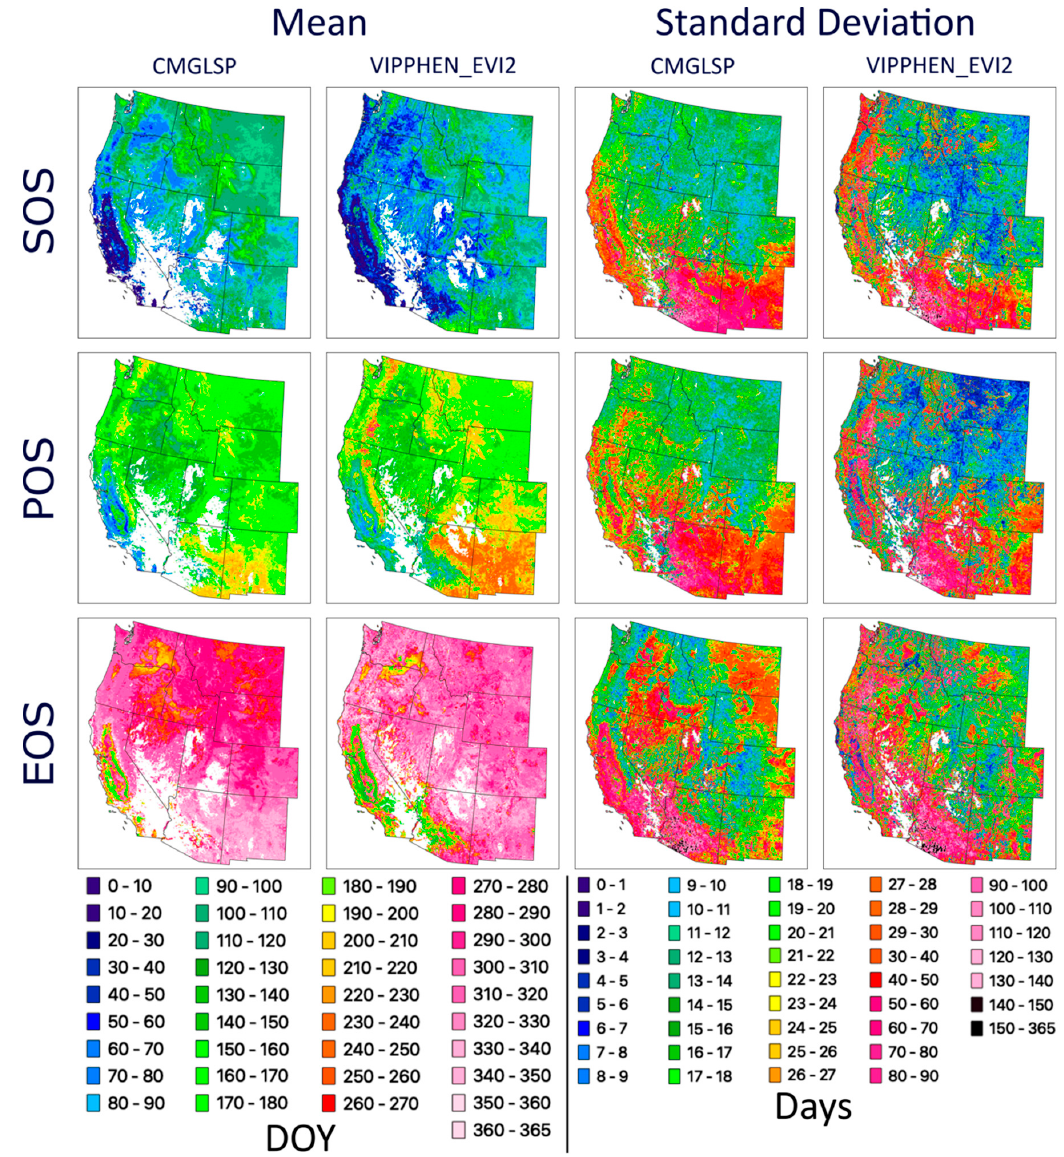
Figure A1. Mean and standard deviation of historical (1982–2016) data from CMGLSP and VIPPHEN_EVI2.